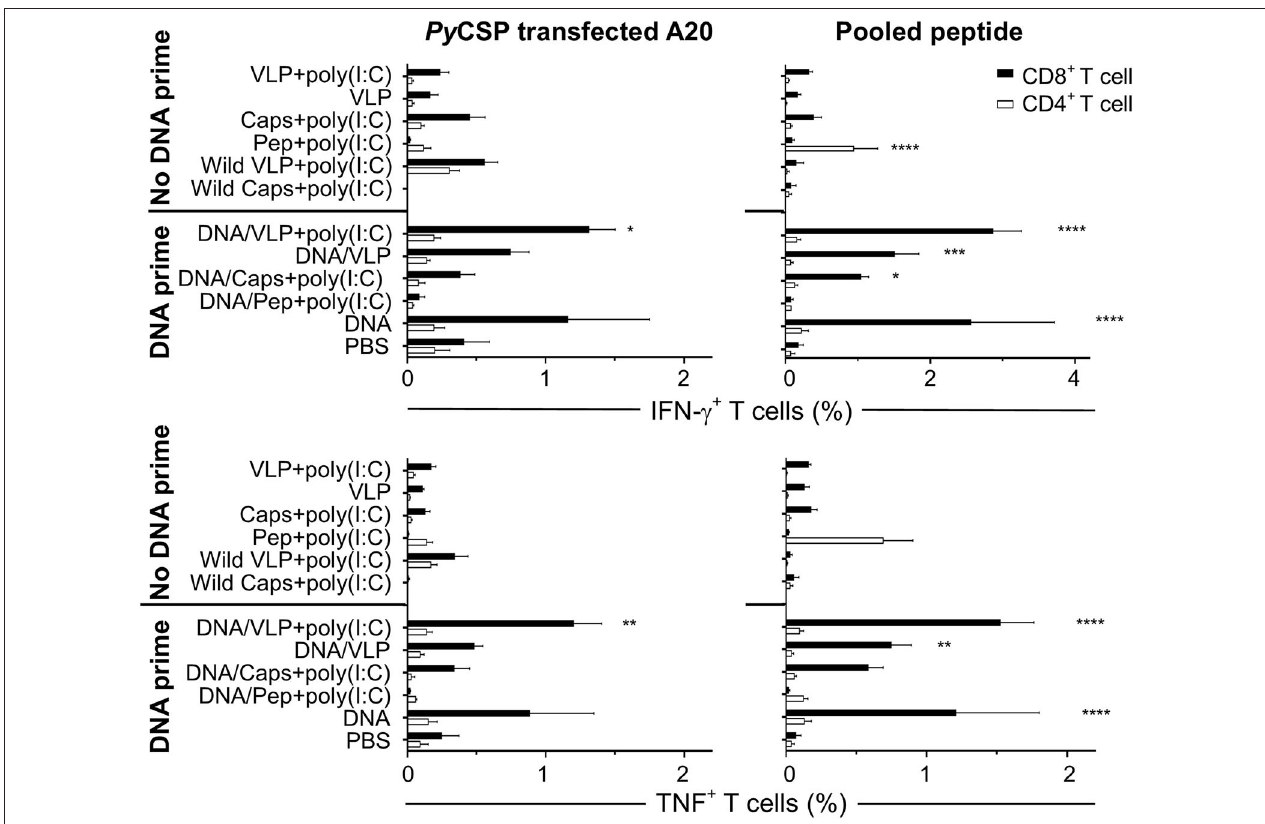
FIGURE 3 | Flow cytometry frequency of stimulated splenocyte CD8 + and CD4 + T cells expressing IFN- γ and TNF post-immunization. BALB/c mice ( n = 5/group) received three immunizations with either homologous (No DNA prime) or a heterologous DNA prime-boost regimen (DNA prime) as described in Figure 1 . Seven days after the final immunization splenocytes were harvested and single-cell suspensions were stimulated in vitro by culturing them with irradiated A20 cells either transfected with PyCSP plasmid DNA or pulsed with Py CSP CD8 + and CD4 + T cell and B cell repeat peptides and incubated in for 1h before adding Golgi Plug followed by a further 5h incubation. Cells were stained for CD8 and CD4 receptors, then permeabilized and stained for IFN- γ and TNF cytokines then assessed by flow cytometry. The frequency of CD8 or CD4 positive cytokine-expressing cells are shown as the group mean + SEM ( n = 5 mice/group) with CD8 + and CD4 + T cells represented by solid black bars or open bars, respectively. Statistical comparisons made to the PBS control group with significance determined using one-way ANOVA with Bonferroni’s post-test. * p < 0.05, ** p < 0.01, *** p < 0.001, and **** p <